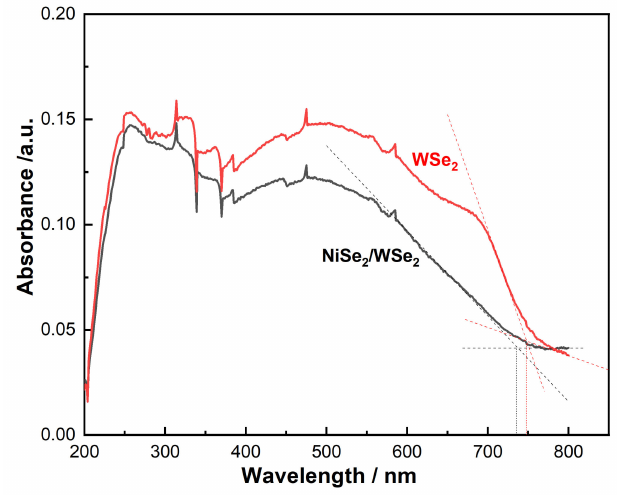
Figure 8. UV-visible absorbance